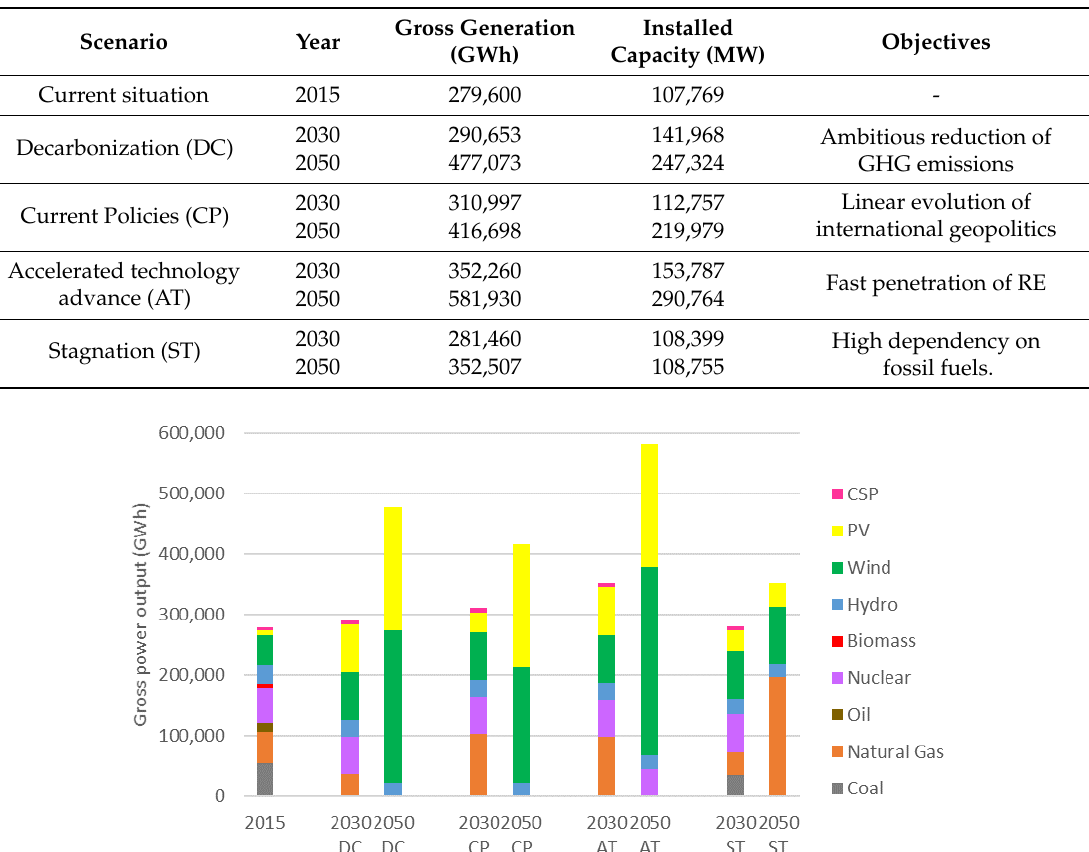
Table 1. Summary of projected electricity scenarios for Spain, as extracted from [27,28].